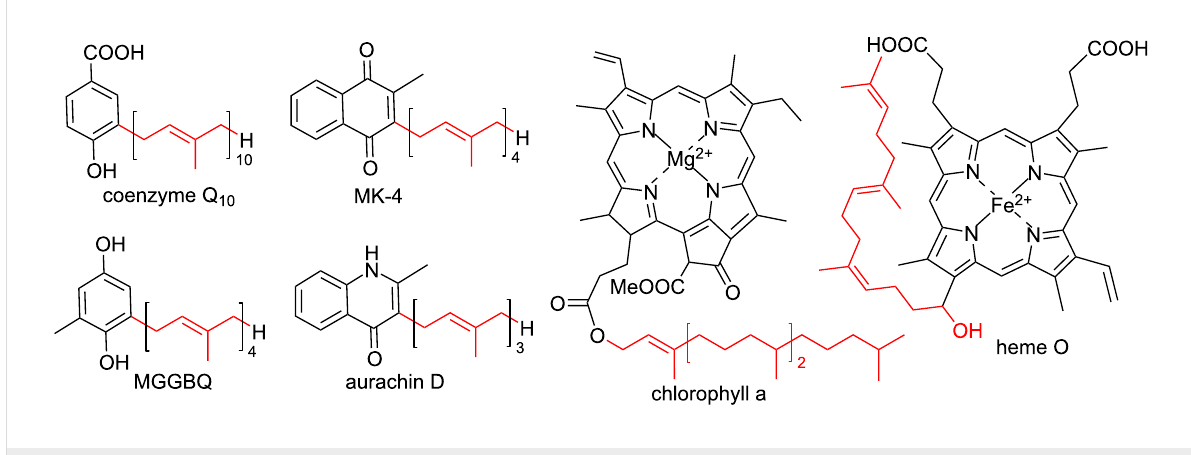
Figure 1: Prenylated aromatic metabolites are involved in cellular processes like cell respiration (coenzyme Q 10 ), cell growth and survival (menaquinone MK-4), photosynthesis (chlorophyll a), oxygen reduction (heme O), and biosynthesis of secondary metabolites (MGGBQ: 2-methyl-6- geranylgeranyl-1,4-benzoquinol and aurachin